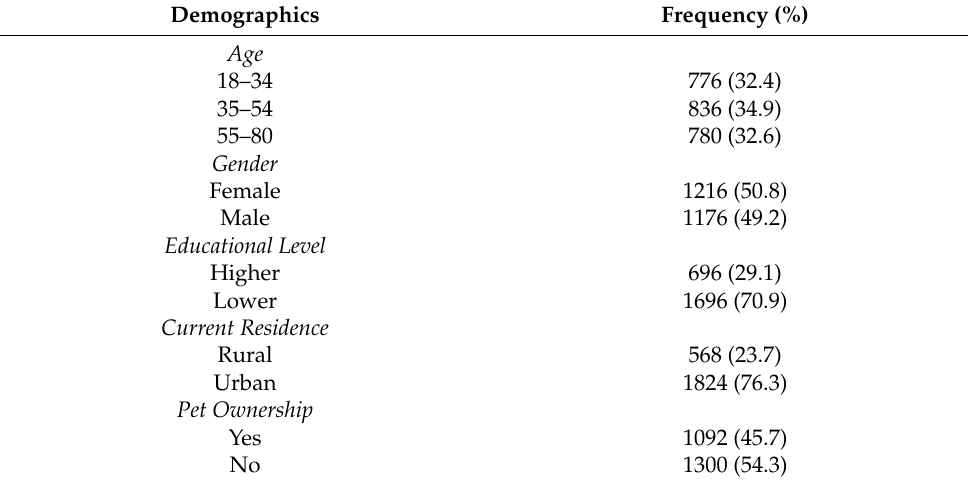
Table 1. Demographic characteristics of the sampled Greek population ( n = 2392).